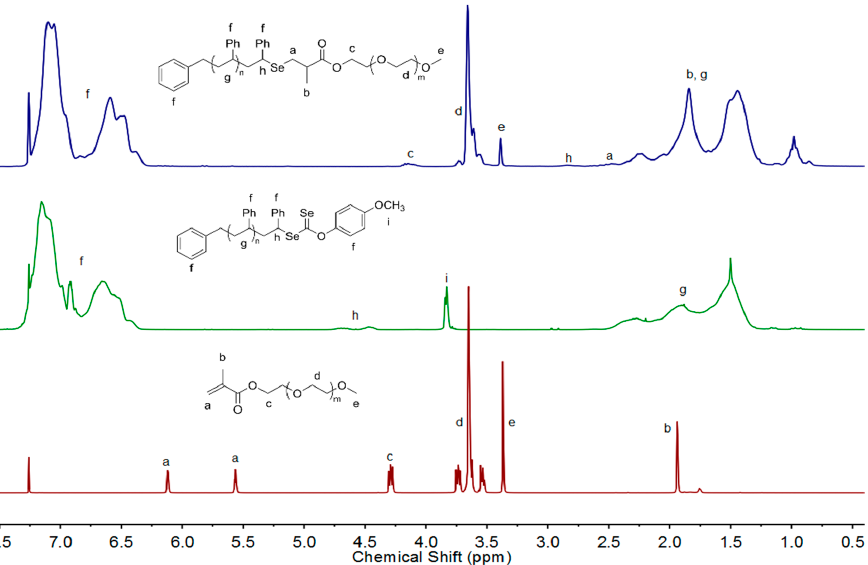
Figure 4. 1 H NMR (in CDCl 3 ) spectrum of PS-Se-1- b -PEGMA 320 ( M n,SEC = 2700 g mol − 1 , Ɖ = 1.09).